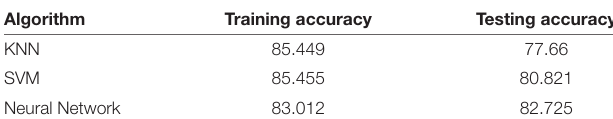
TABLE 3 | Accuracy of different algorithms.